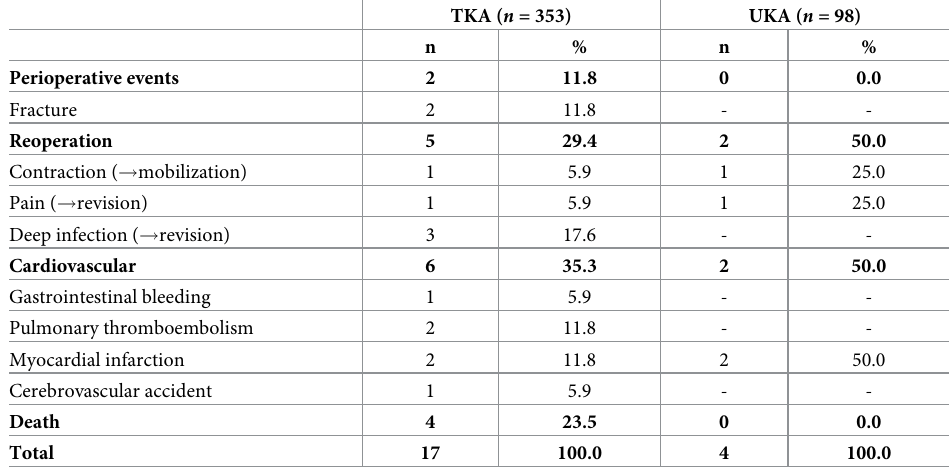
a Corresponded to adverse events as defined in the Swedish Knee Arthroplasty Register’s 45 th Annual Report [1].